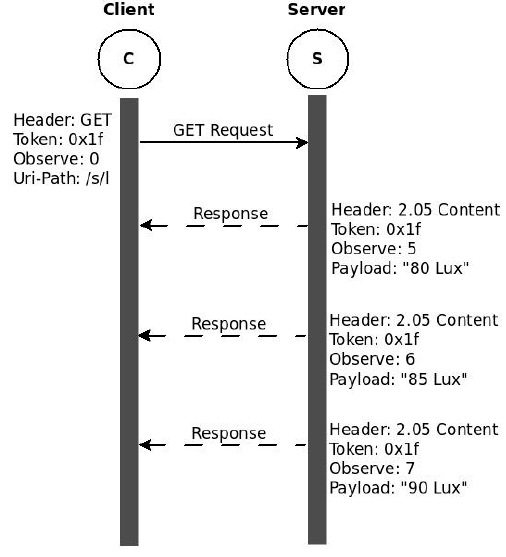
Figure 3. CoAP Observe Operation.